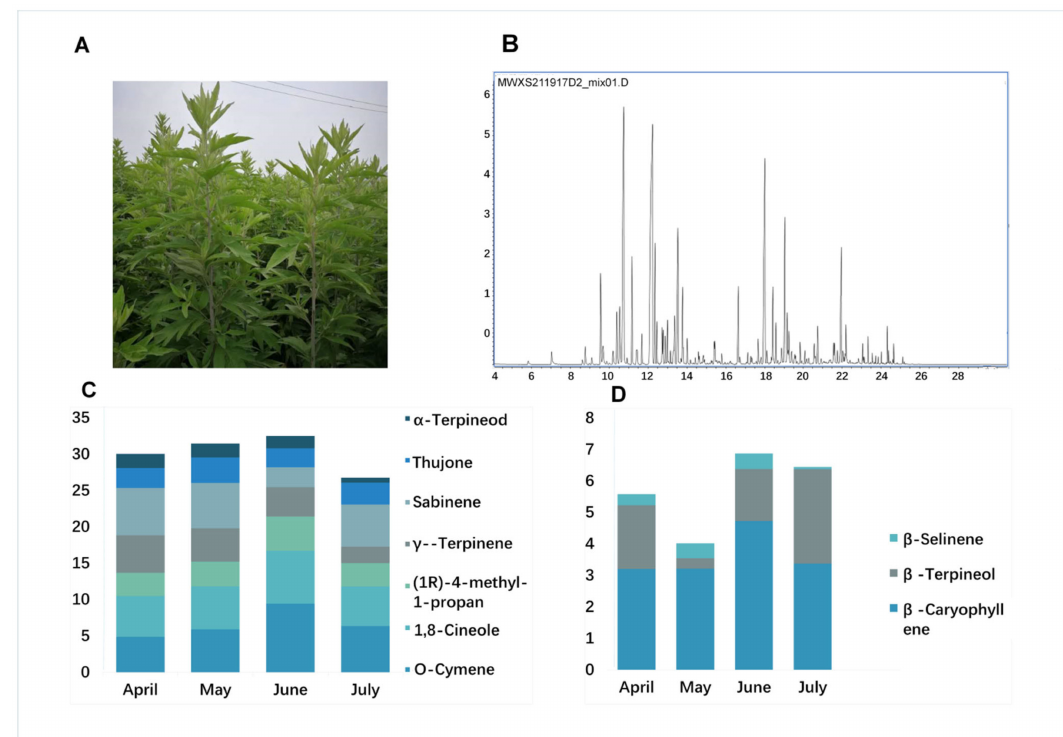
Figure 1. GC–MS chromatograms and terpenoid contents in A. argyi . ( A ) A. argyi plants cultivated under field conditions. ( B ) GC–MS total ion chromatograms of volatile compounds from A. argyi leaf samples collected in April, May, June, and July, respectively. ( C ) Bar graph corresponding to the distribution of levels of seven monoterpenes in A. argyi samples collected at four time points. ( D ) Bar graph corresponding to the distribution of levels of three sesquiterpenes in A. argyi samples collected at four time